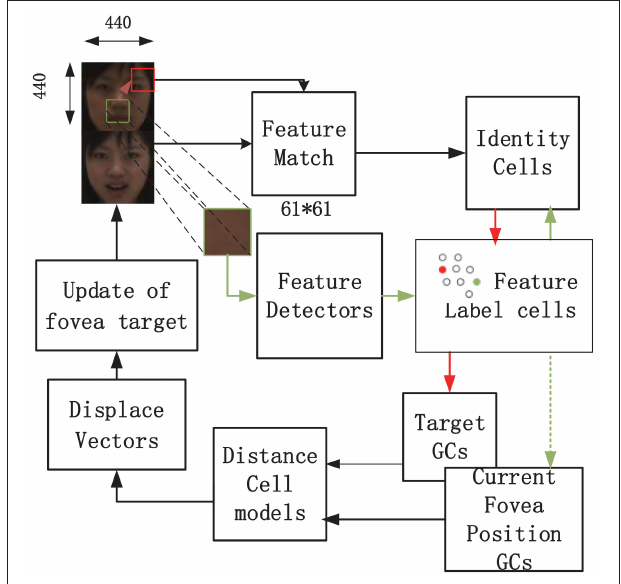
FIGURE 1 | The model schematic of the visual recognition model based on grid cells, as proposed in Bicanski and Burgess